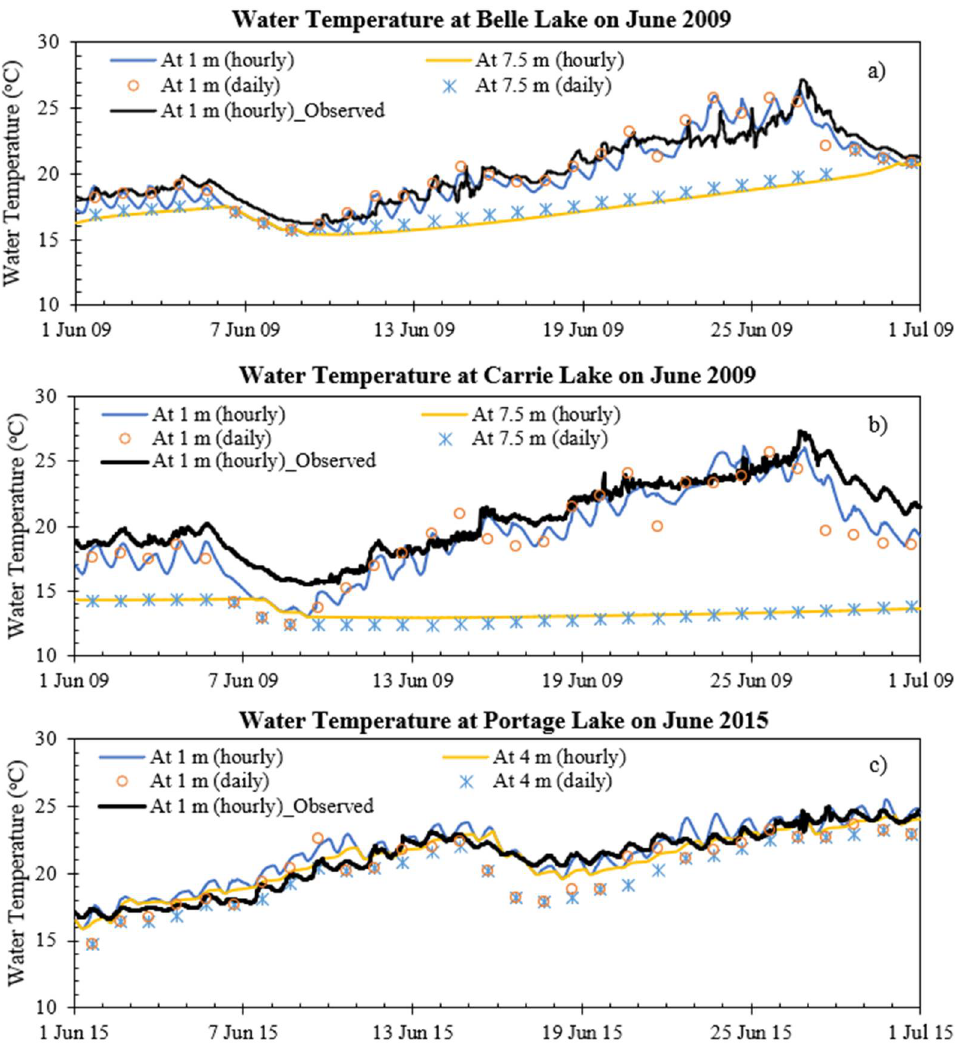
Figure 10. Time series of simulated daily and hourly water temperatures at two depths (1 m, 7.5 or 4 m) at ( a ) Belle Lake in June 2009, ( b ) Carrie Lake in June 2009, and ( c ) Portage Lake in June 2015 including observed hourly surface temperatures. Daily values were plotted at 4:00 p.m. each day.